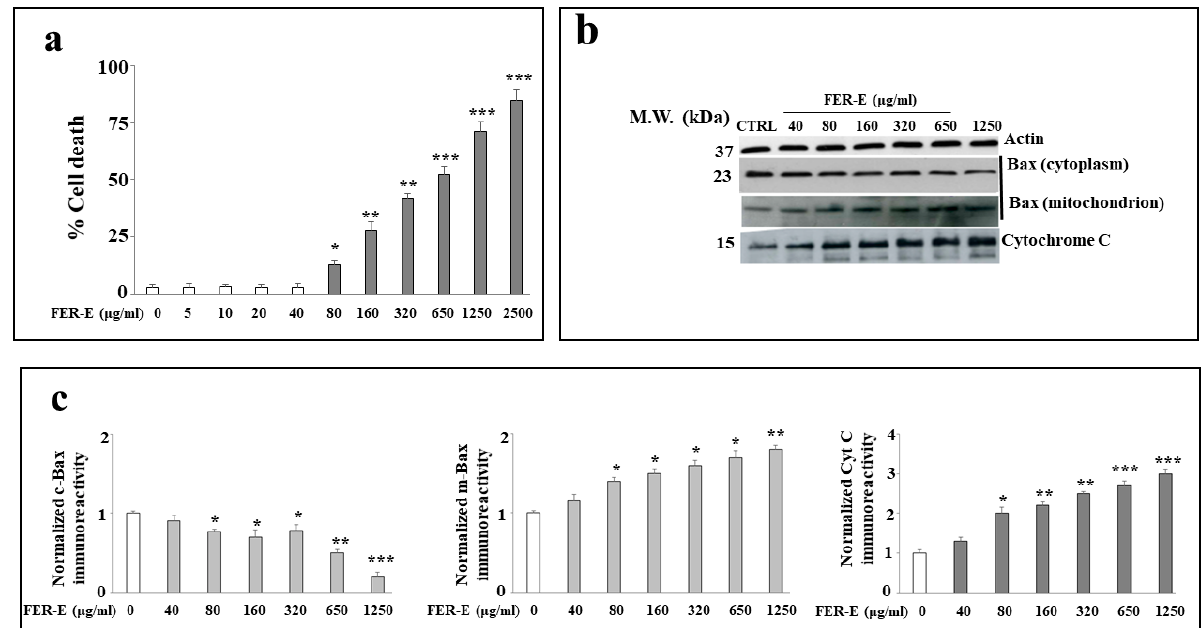
Figure 1. Effects of FER-E on cell viability. Exposure of FER-E to the cell line MCF-7 produces two effects: low concentrations (5–40 µ g/mL) appear non-toxic, while high concentrations (80–2500 µ g/mL) result in a gradual and significant increase in mortality, as shown in ( a ). In ( b ), the expression of proteins Cytochrome C and Bax (cytoplasmic and mitochondrial), both linked to the induction of apoptosis, was evaluated following treatment with increasing concentrations of FER-E, as shown in the figure. Results have been normalized thanks to the hausekeeping protein actin. In ( c ), the respective quantifications are shown. Three independent experiments were carried out, and the values were expressed as the mean ± standard deviation (sd). * denotes p < 0.05 vs. the control; ** denotes p < 0.01 vs. the control; *** denotes p < 0.001 vs. the control. Analysis of Variance (ANOVA) was followed by a Tukey–Kramer comparison